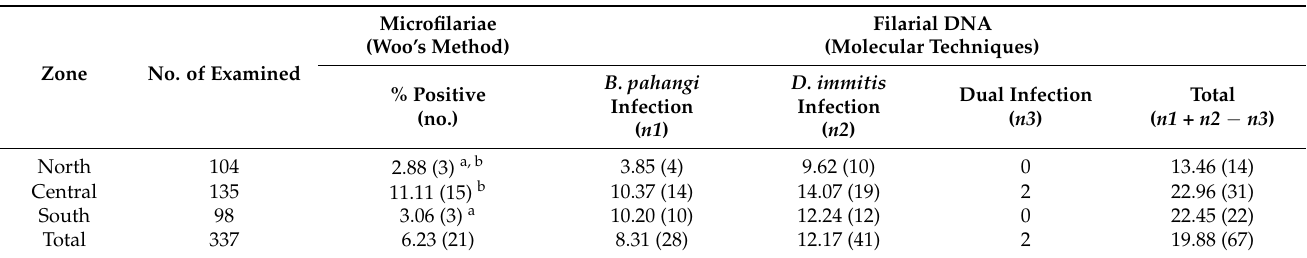
Table 2. Prevalence of microfilariae and filarial nematode species in the community dogs among three zones of Chiang Mai,